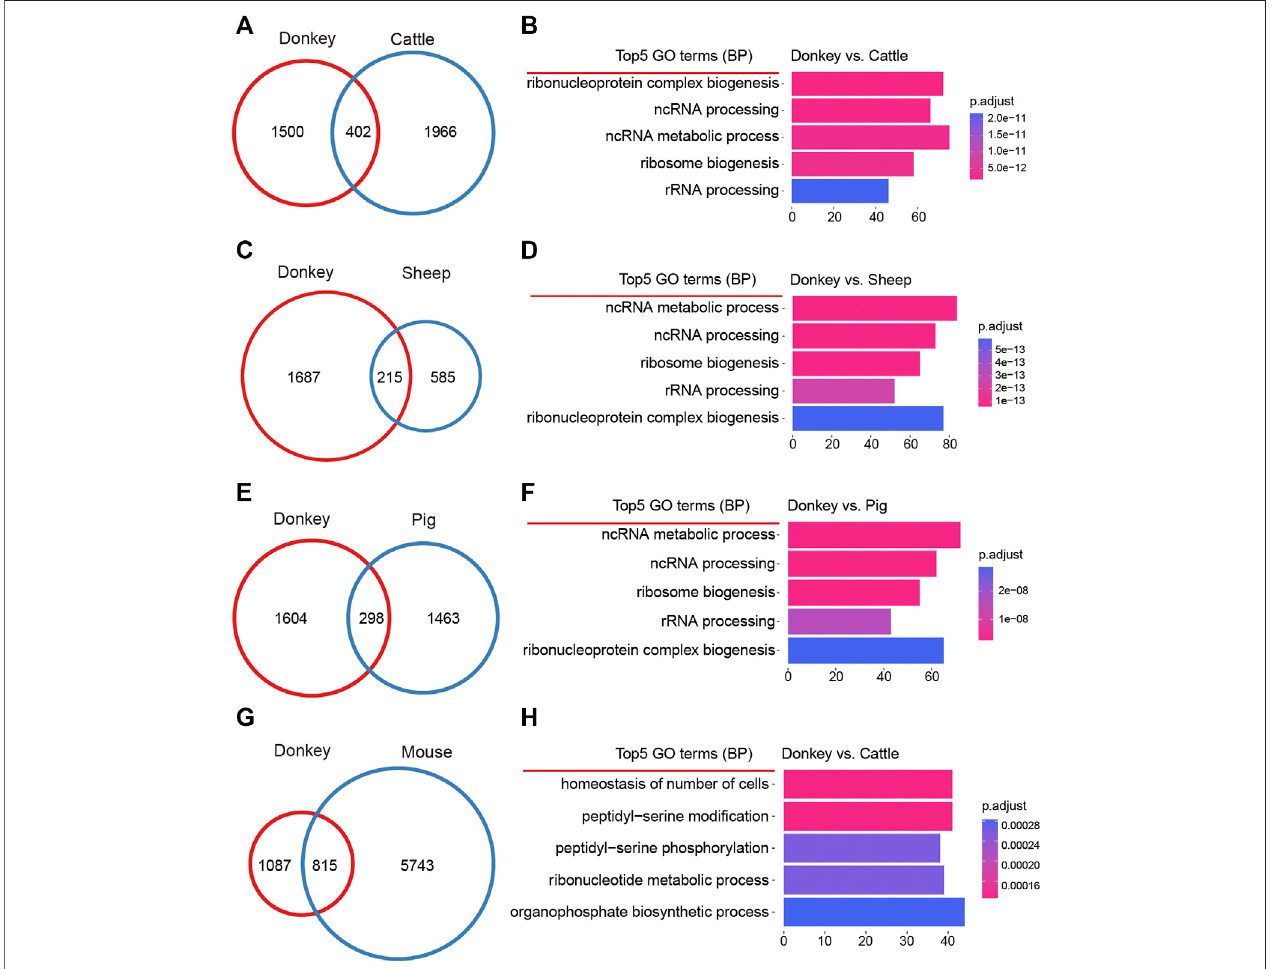
FIGURE 3 | Comparative analysis of donkey oocyte development during the period from germinal vesicle (GV) to metaphase II (MII). (A) The differences in oocyte developmentbetweendonkeysand cattleduringGV – MII. (B) Thetop5GO(biologicalprocess) termsofdonkeyuniquedifferentiallyexpressed genes(DEGs)compared to cattle. (C) The differences in oocyte development between donkeys and sheep during GV – MII. (D) The top5 GO (biological process) terms of donkey unique DEGs compared to sheep. (E) The differences in oocyte development between donkeys and pigs during GV – MII. (F) The top5 GO (biological process) terms of donkey unique DEGs compared to pigs. (G) The differences in oocyte development between donkeys and mice during GV – MII. (H) The top5 GO (biological process) terms of donkey unique DEGs compared to mice.